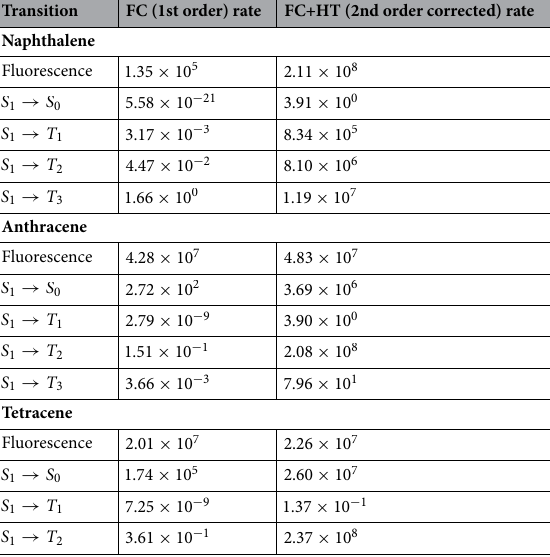
Table 3. Tabulated rate constants with the Franck–Condon (FC) and Herzberg–Teller corrected (FC+HT) regimes for naphthalene, anthracene, and tetracene, given in units of s − 1 . Rates for anthracene and naphthalene were taken with permission from Ref. 10